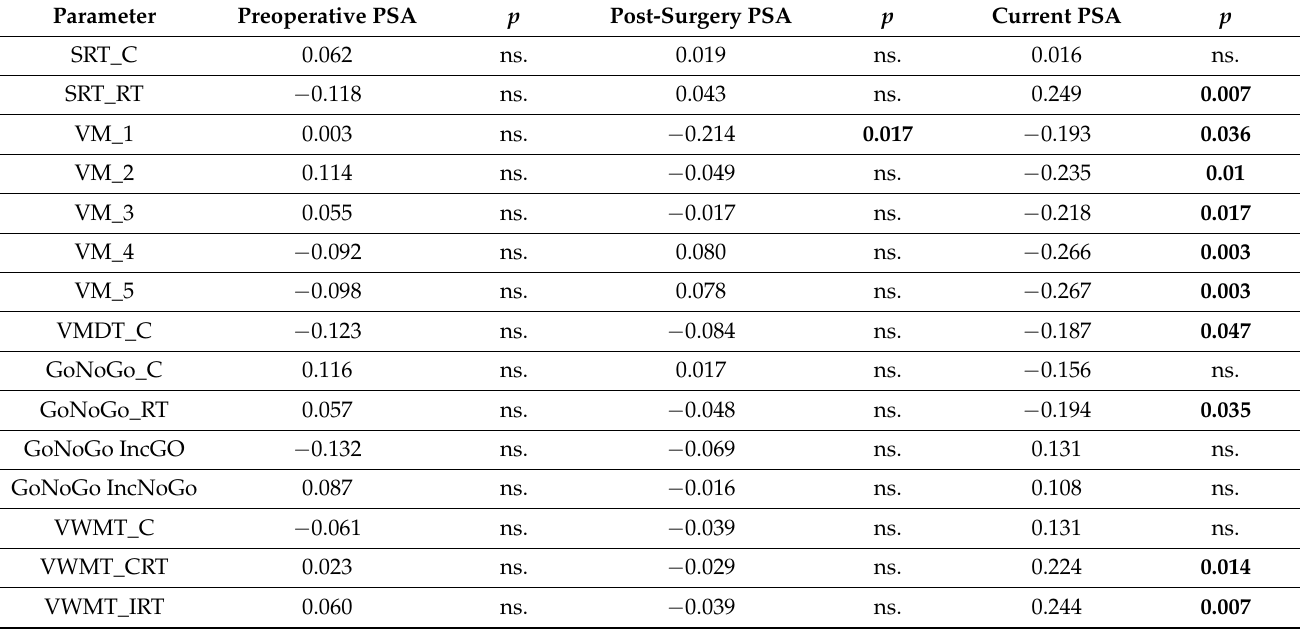
Table 3. R-Spearman correlations of cognitive test results and PSA pre, post, and current.